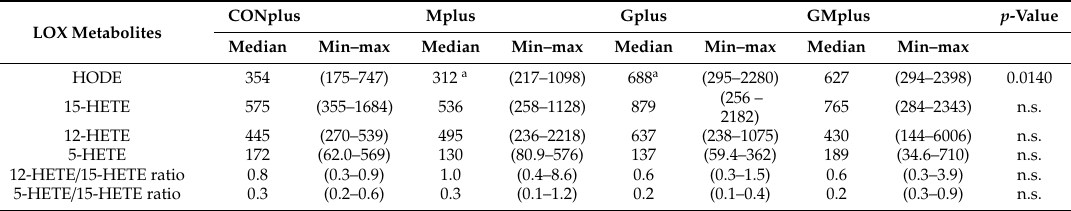
Table 6. Content of linoleic acid (LA) and arachidonic acid (AA) LOX metabolites (ng / g of tissue) in tumours of experimental groups.